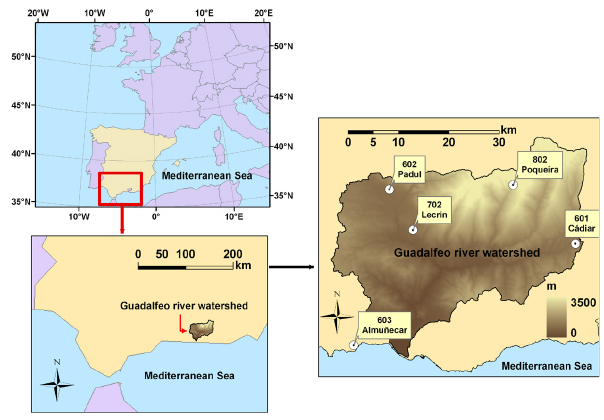
Fig. 1. Guadalfeo River Watershed, weather stations and